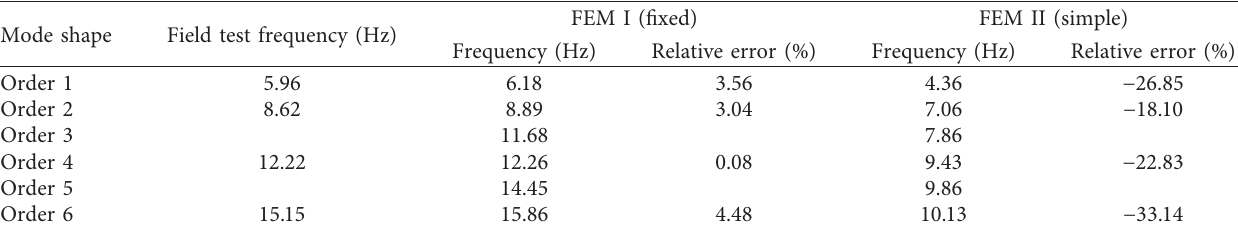
Table 6: Comparison of FEM and experimental test frequency.